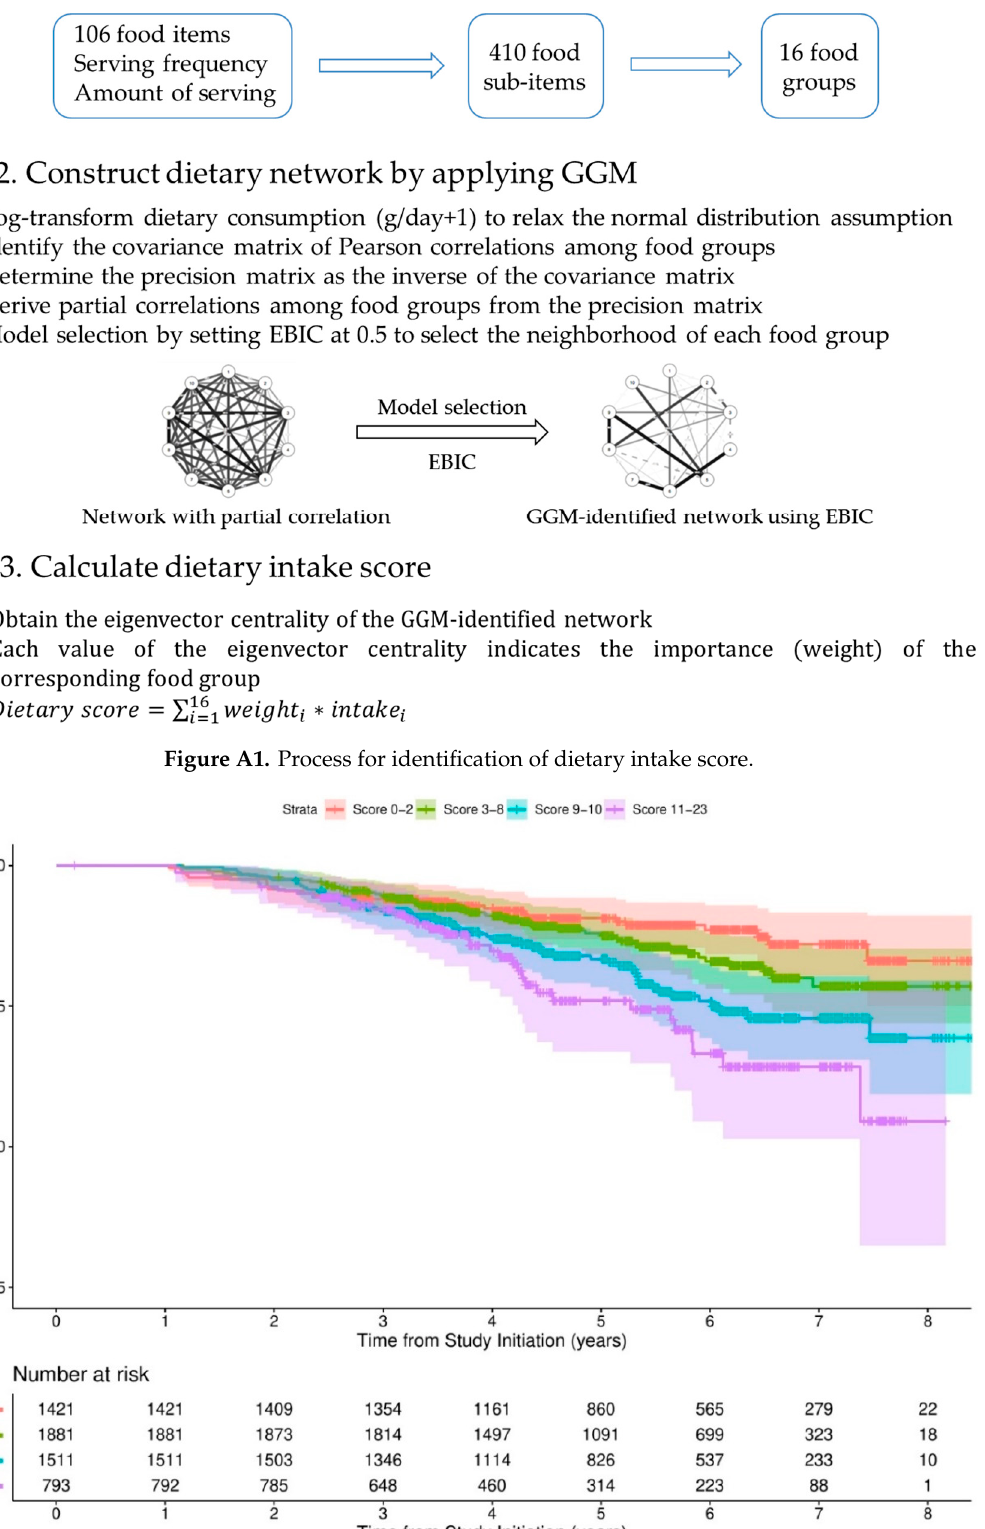
Figure A3. Kaplan–Meier estimates of cancer-free probability by comorbidity risk scores in subjects regardless of time to cancer diagnosis.